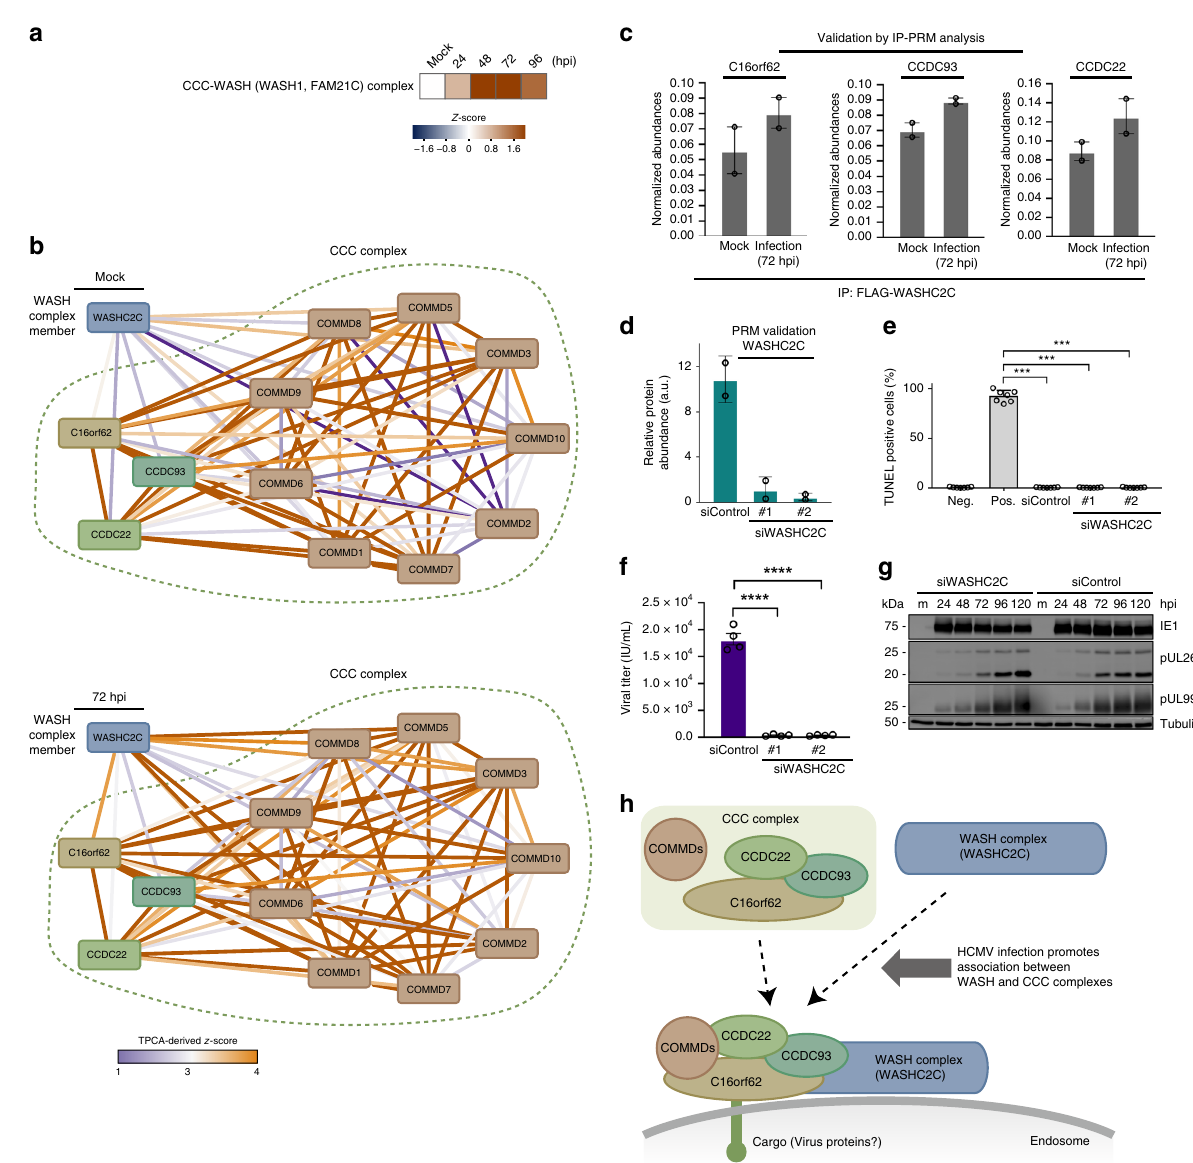
Fig. 3 HCMV infection enhances the stability of the CCC-WASH protein complex that is needed for virus production. a Heat map of z -scores for the CCC-WASH complex at each infection time point. b Network plot of proteins involved in CCC-WASH complexes in mock and infected (72 hpi) cells. Edge width and color indicate transformed Euclidean distance between nodes and their z -score, respectively. Low z -score suggests a weak association (lines with blue tones), while a high z -score suggests a stronger association (lines with orange tones) between proteins. c Validation of the stabilization of the CCC- WASH complex by IP-PRM analysis. FLAG-tagged WASHC2C IPs were performed in mock and infected (72 hpi) cells, and the normalized protein abundances were determined by PRM for C16orf62, CCDC93, and CCDC22. Data are mean ± SEM ( n = 2). d PRM validation of WASHC2C siRNA- mediated knockdown. Data are mean ± SD ( n = 2). e TUNEL assay for cells transfected with siRNAs targeting WASHC2C or siControl, n ≥ 6, *** p -value < 0.001. f Viral titers from cells transfected with siRNAs targeting WASHC2C or a non-targeting siRNA control. Data are mean ± SEM and a two-sided Student ’ s t -test was performed, n = 4 biological replicates, **** p -value < 0.0001. g Western blot showing viral protein levels for each of the three temporal classes for siWASHC2C cells or siControl cells. Source data are provided as a Source Data fi le. h Proposed model for the enhanced association between the CCC complex and the WASH complex during HCMV infection. HCMV infection promotes the stabilization of the CCC complex and the gain of interaction between the CCC and WASH complexes on the endosome membrane to support the intracellular transport of proteins from CORUM (Fig. 4d and Supplementary Fig. 4c). The Euclidean distances between protein aggregation pro fi les indi- cated that, while ITGB1 and collagen (COL1A1) or fi bronectin (FN1) became gradually distant during infection, ITGB1 and CD63 became closer. CD63 activates ITGB1 and promotes integrin signaling 49 , as well as enhances the internalization of several plasma membrane proteins 49,50 . Our results suggest that CD63 may similarly promote ITGB1 internalization during